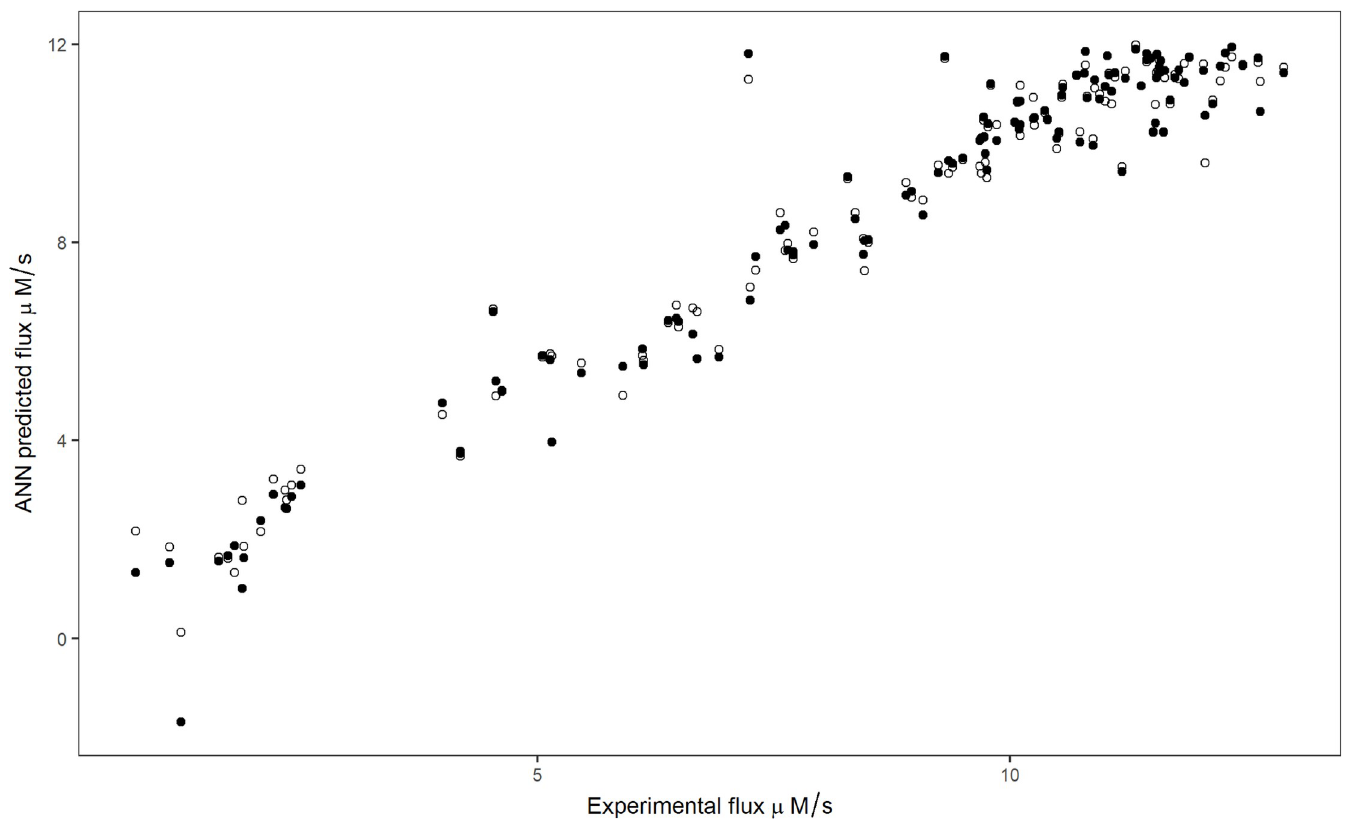
Fig 4. Relationship between flux predicted by leave-one-outcross-validation and experimental flux. Filled and open circles represent logistic and tanh activation functions respectively.